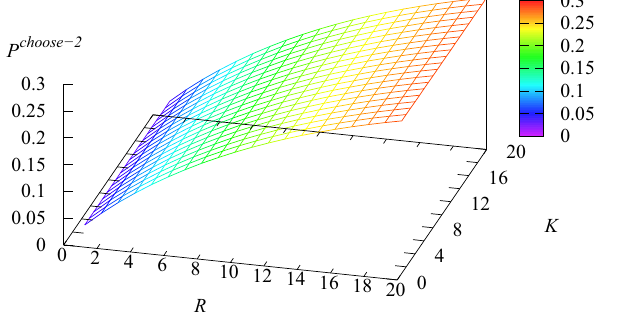
Figure 15. Dependence of the probability P choose − 2 that an arbitrary Type-2 request will be selected for service from the second buffer without visiting the main buffer on K and R